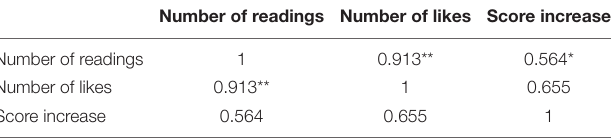
TABLE 2 | Pearson correlation test of CSR reading related to corporate shareholders, number of likes, and